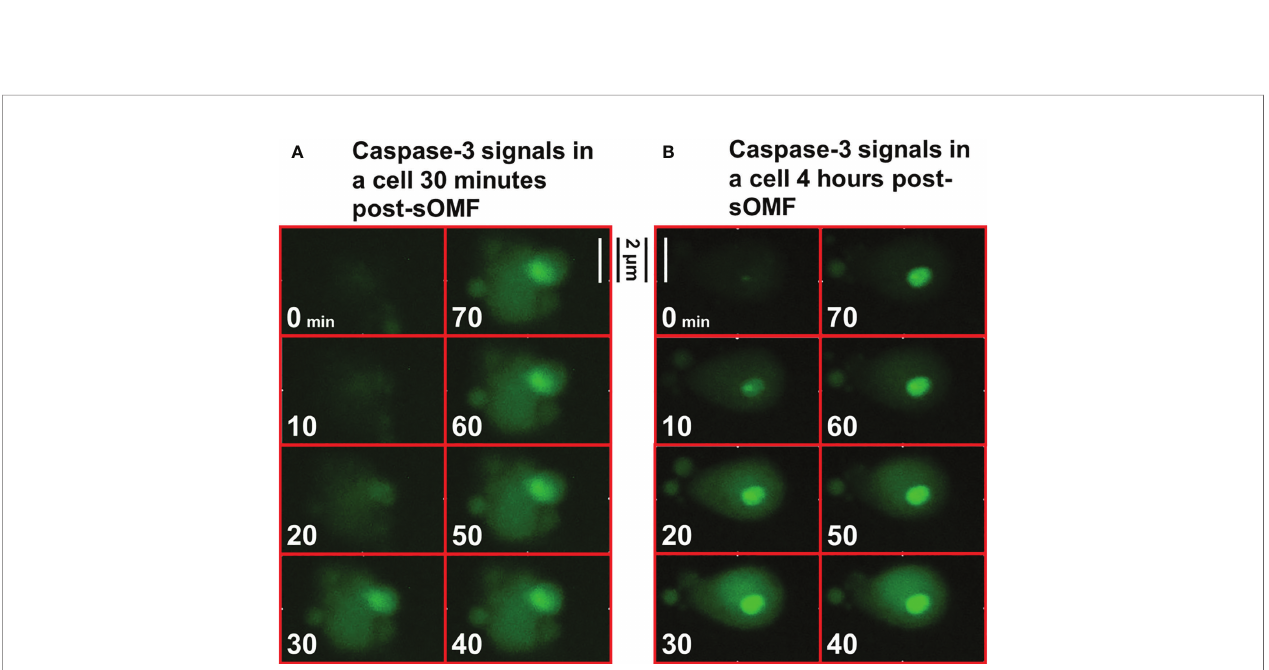
FIGURE 9 | High resolution images of the activation of caspase-3/7 in sOMF treated GBM. GBM cells were loaded with NucView Caspase-3/7 Green, washed, and then returned to media. Time-lapse fl uorescence images were acquired every 10 minutes for 16 hours. The cells underwent sOMF for 4 hours, and post-treatment apoptosis was monitored for a further 12 hours. We picked two representative cells that can be observed to undergo rapid caspase-3/7 activation, the fi rst (A) some 30 minutes and these second at 4 hours (B) post-sOMF therapy. We show movies stills, taken 10 minutes apart, to show the time dependency of caspase-3/7 activation in these GBM